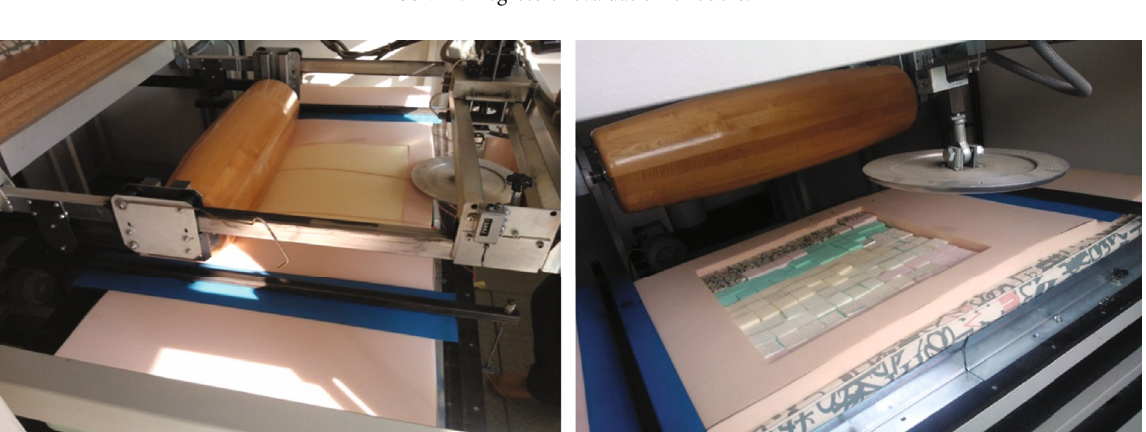
Figure 2: Degrees of evaluation of odors.